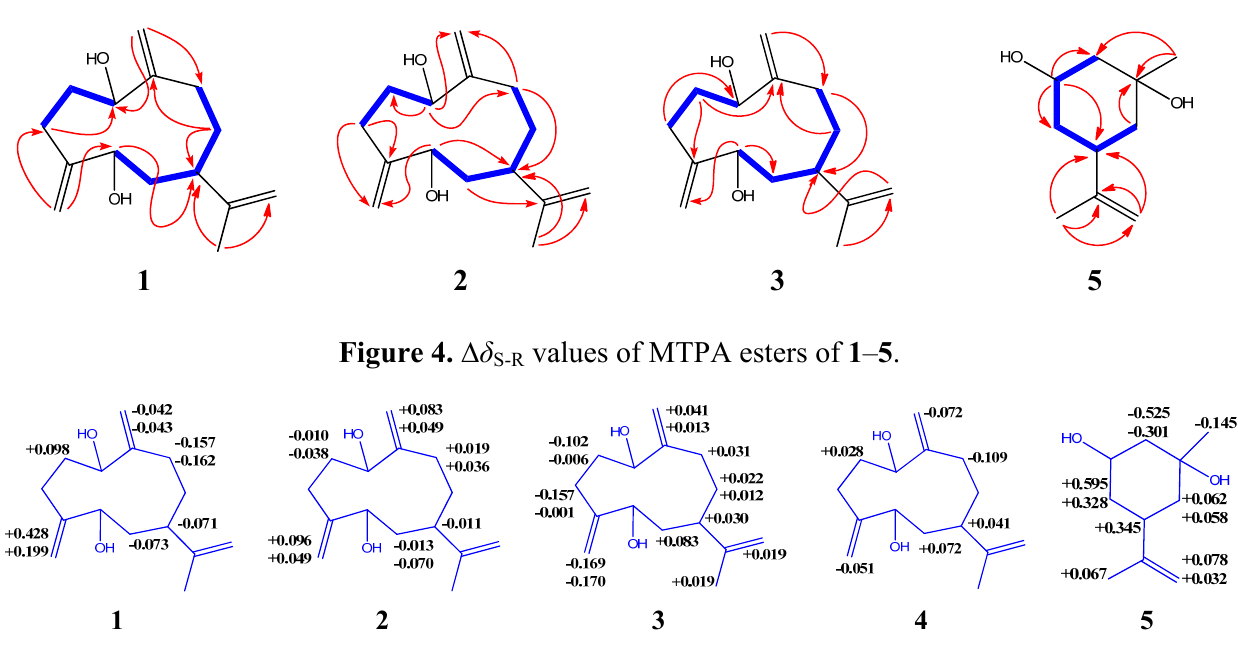
Figure 3. Selected 1 H- 1 H COSY ( — ) and HMBC ( → ) correlations of compounds 1 – 3 , 5 .